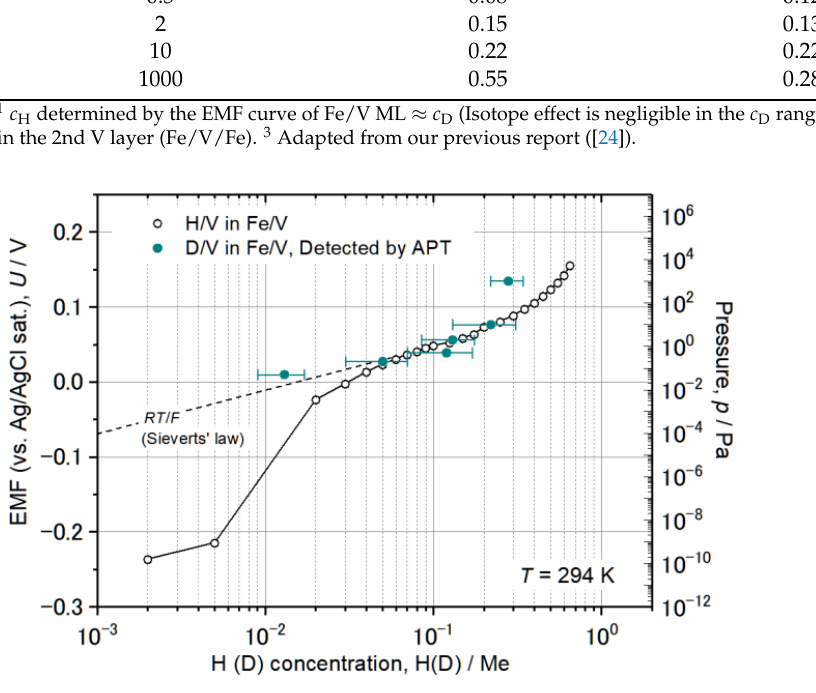
Table 1. Comparison of mean D concentration c D [D/Me] obtained by the EMF curve and APT. Mean D Concentration, c D [D/Me] D 2 Pressure [Pa] Expected by EMF 1 Detected by APT 2 0.05 0.035